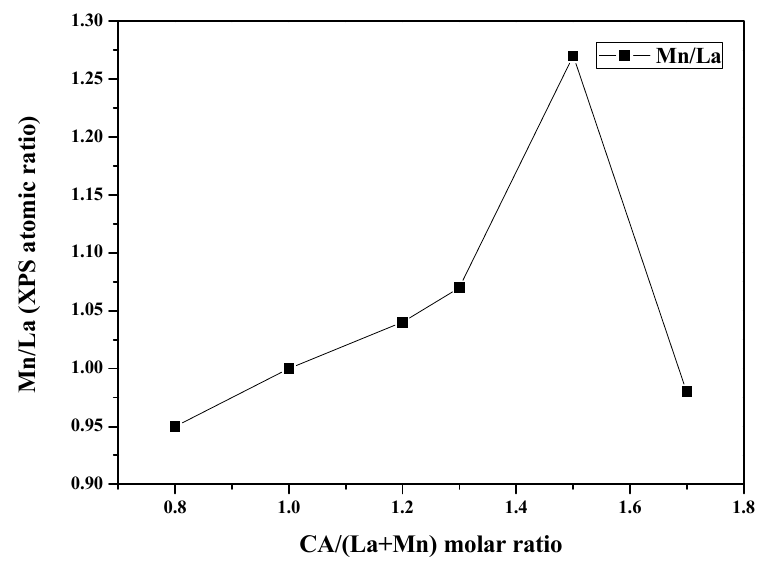
Figure 8. Relationship between the Mn/La surface atomic ratio and the molar ratio of CA to total metal